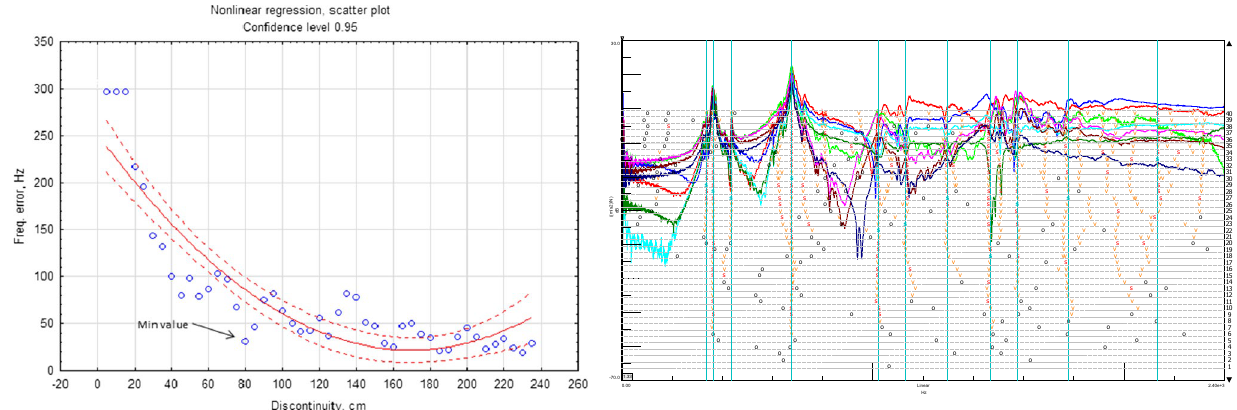
Fig. 11 The results of estimation of the grout length: the characteris- tics of the transfer function for the analyzed case, the vertical axis of the chart—inertance, in (m/s 2 )/N, the horizontal axis—frequency, in